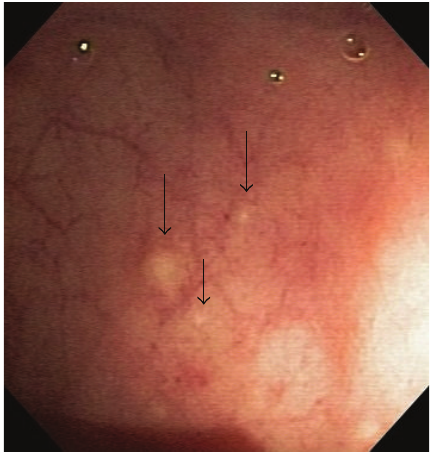
Figure 1: Colonoscopic view of yellowish subepithelial nodes in rectum (black arrows).